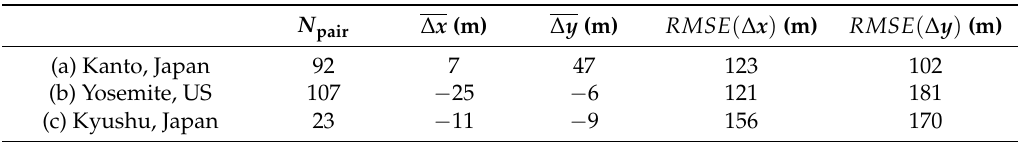
Table 4. Mean miss-registration errors and RMSEs of matched feature pairs extracted from the projected VIS images and OLI images. Symbols ∆ x and ∆ y represent the east–west and north–south directions, respectively. N pair ∆ x (m) ∆ y (m) RMSE ( ∆ x ) (m) RMSE ( ∆ y )